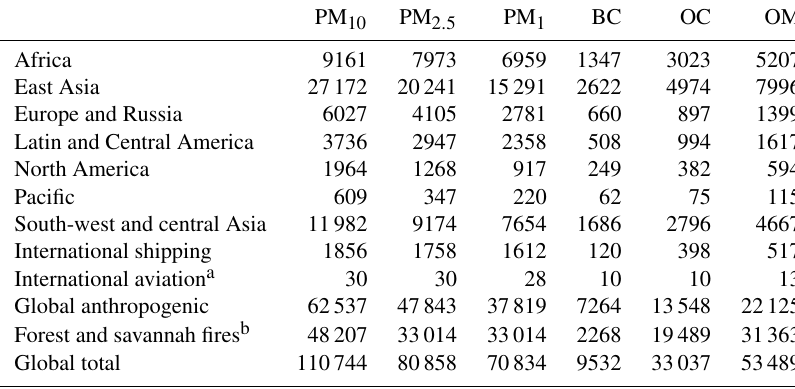
Table 7. Regional emissions of particulate matter in 2010, ECLIPSE V5a , Ggyear − 1 .